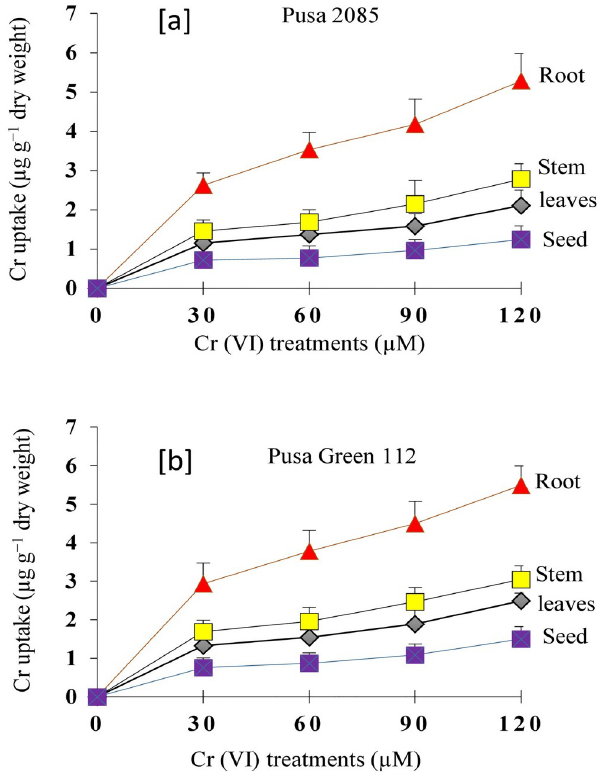
Fig 15. Chromium (Cr) accumulation in roots, stems, leaves, and seeds of Pusa 2085 and Pusa Green 112 chickpea seedlings grown in pots under different Cr concentrations (0, 30, 60, 90 and 120 μ M).